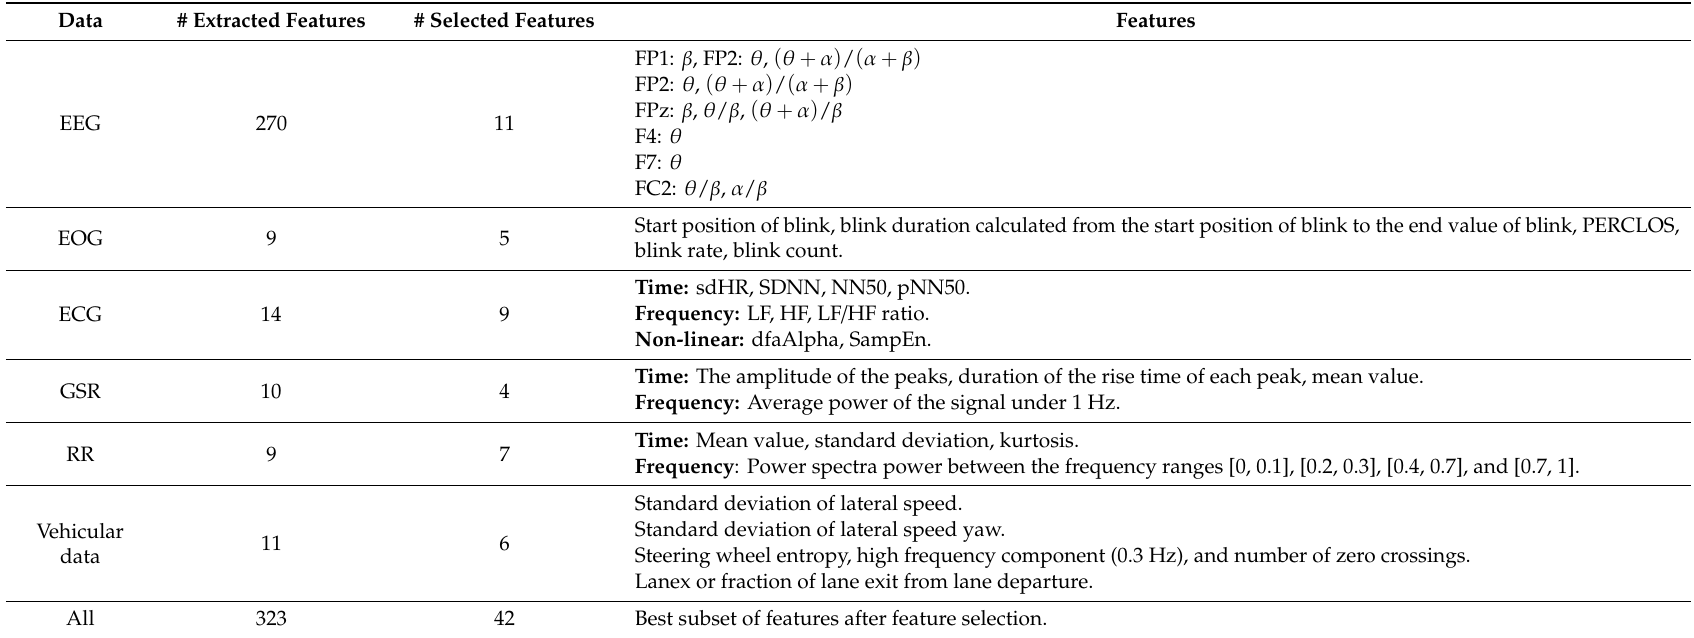
Table 2. List of selected features from each signal. # represent